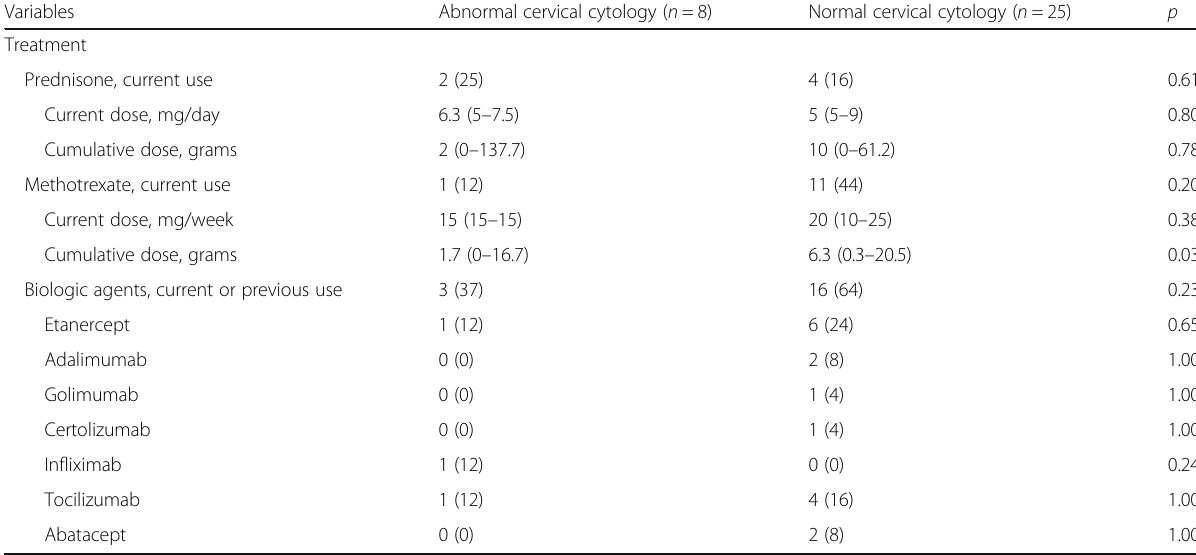
Table 1 Treatments in juvenile idiopathic arthritis (JIA) patients with abnormal and normal cervical cytology